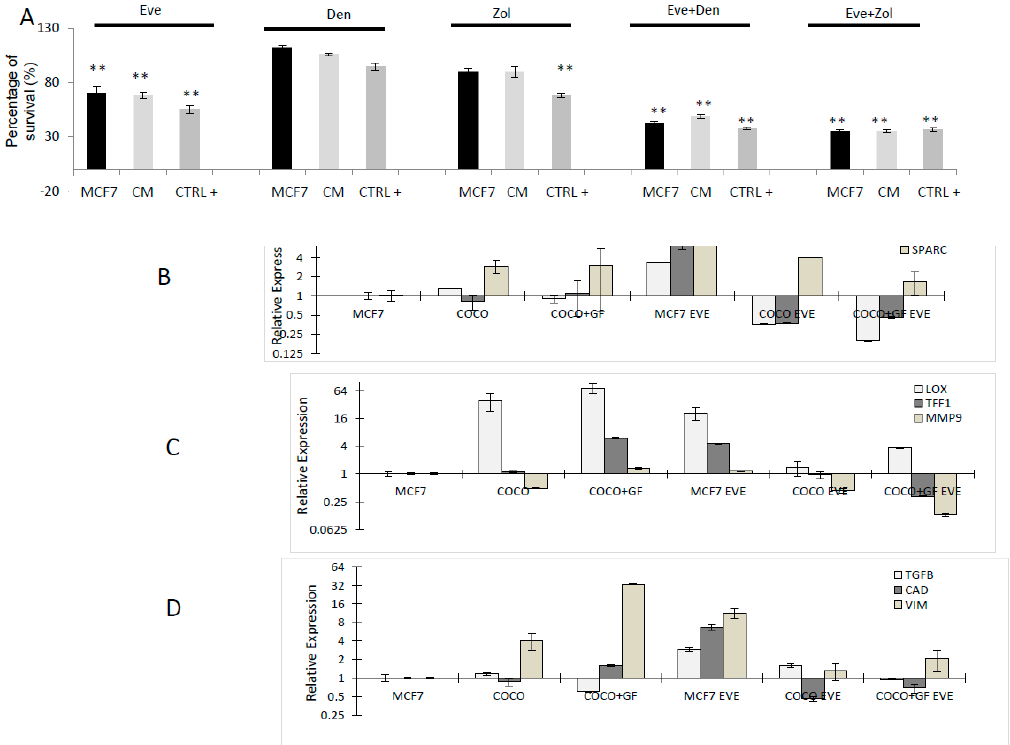
Figure 7. Drug effect on MCF7 CCs. ( A ) MTT analysis on CCs. As Anova analysis of drug effects resulted significant in all conditions (SCP2, CM, DM), Bonferroni Test was performed; in all conditions all drugs significantly decreased survival compared to CTRL − (significance related to the corresponding untreated sample: * p < 0.05 and ** p < 0.001). ( B ) Gene expression analysis on CCs cultured solely and with osteoclasts. Markers of osteomimicry ( B ); CC aggressiveness ( C ); and EMT ( D ) were analyzed in presence/absence of Eve. Data were normalized with respect to untreated MCF7 cultured singularly and graphed on a double logarithmic scale.